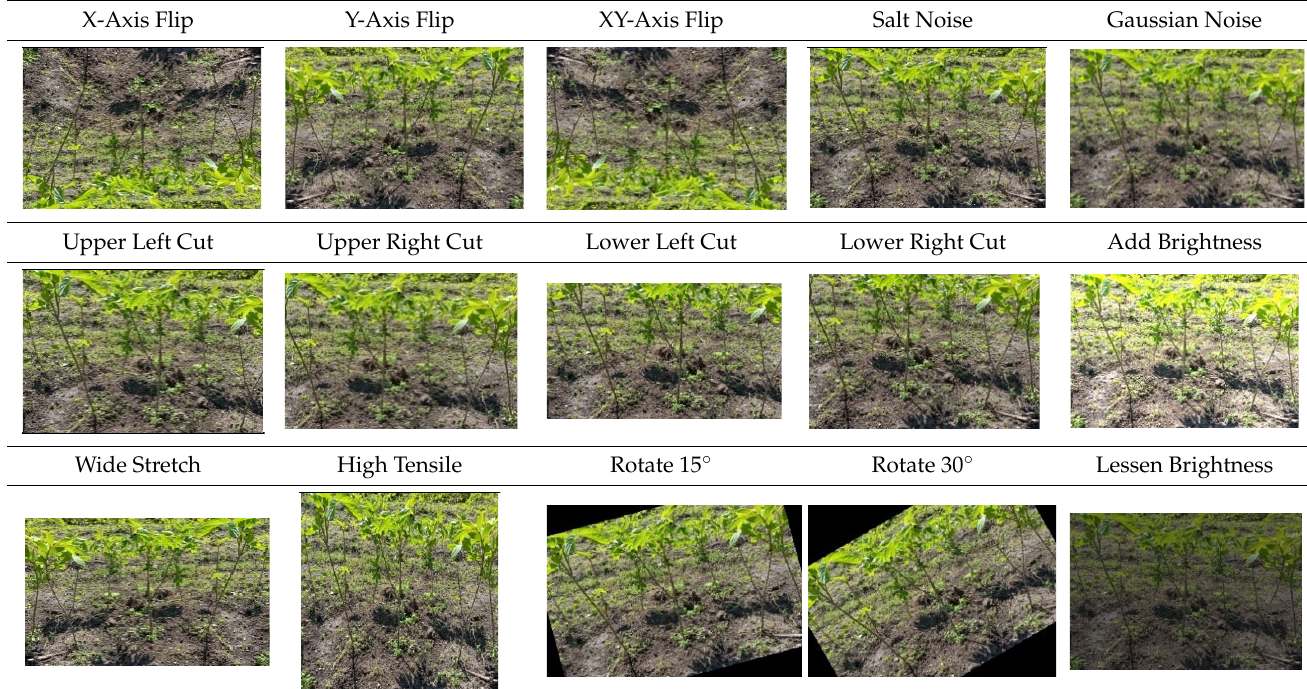
Table 1. Data augmentation dataset examples.